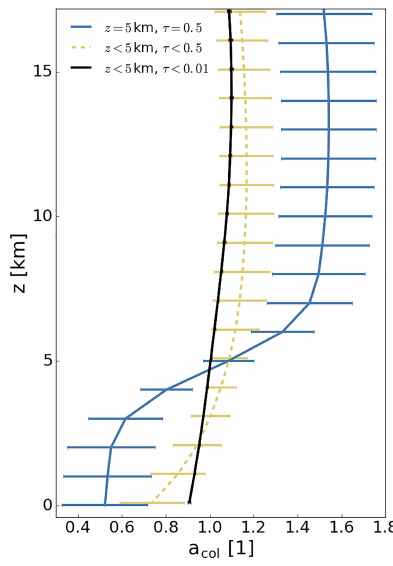
Figure 1. TROPOMI CO total column averaging kernels for 10 November 2017. The global average is shown for three differ- ent categories of cloudiness strict cloud clearing (black), clear-sky equivalent (yellow), and high optical thick clouds (blue). The stan- dard deviation is indicated as error